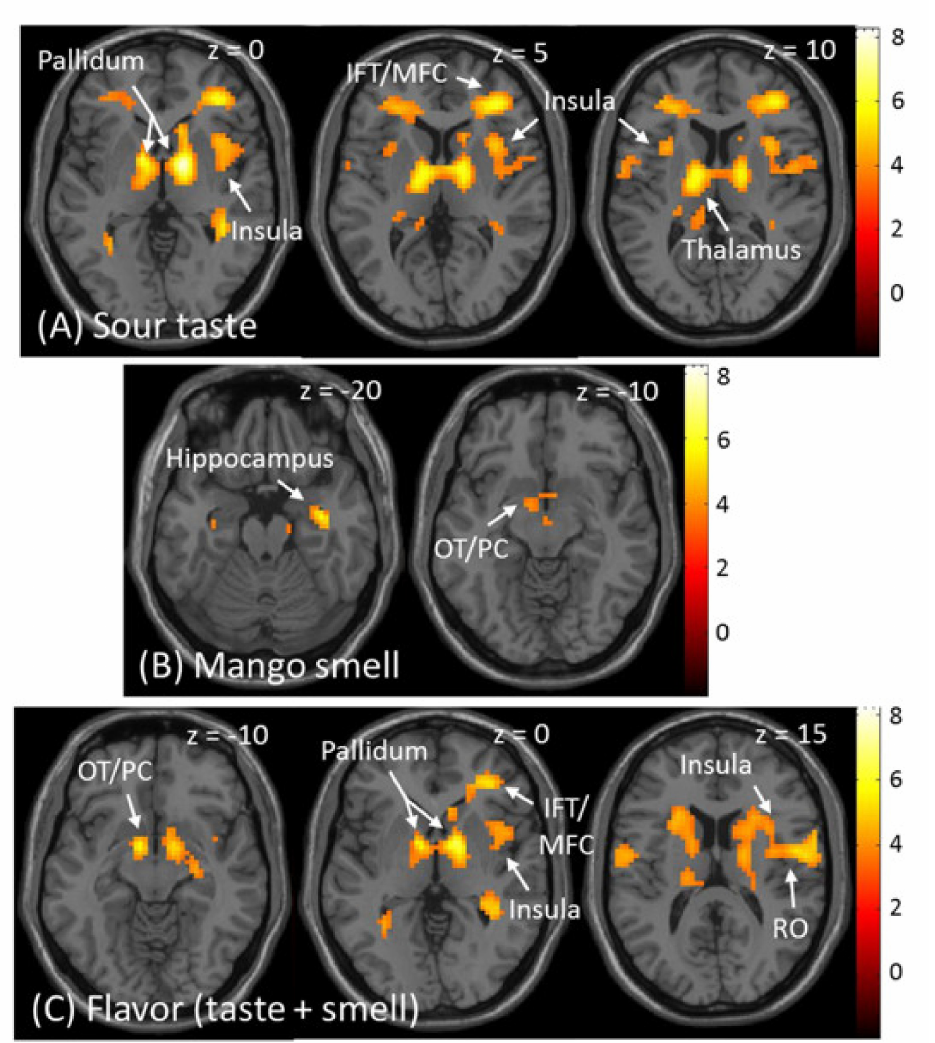
Figure 4. Brain responses in the group-level whole-brain analysis. ( A ) Activated areas by sour taste. ( B ) Activated areas by mango smell. ( C ) Activated areas by the flavour of sour taste plus mango smell. IFT: inferior frontal triangularis; MFC: middle frontal cortex; OT: olfactory tubercle; PC: piriform cortex; RO: rolandic